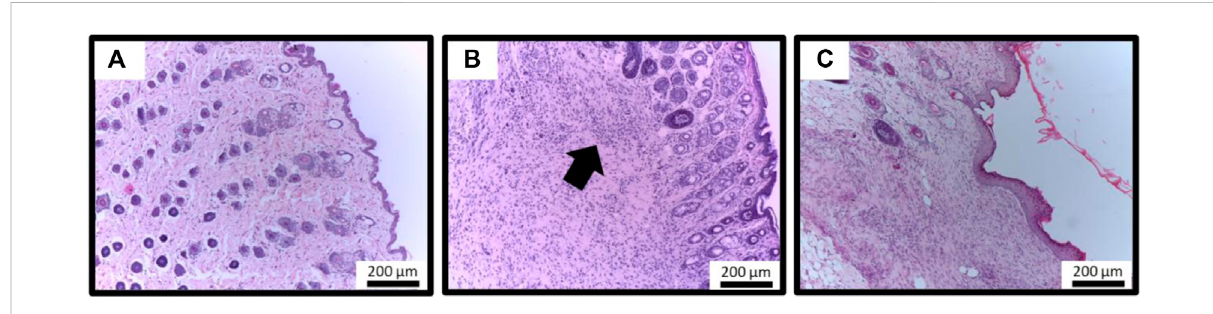
FIGURE 2 Histological evaluation of topical treatment with EbEO. (A) Analysis of wound tissues without S. aureus inoculation (CON group); (B) Analysis of wound tissues infected by S. aureus and without treatment (Sa group); (C) Analysis of wound tissues infected by S. aureus and treated by EbEO (Sa + EbEO group). The intense proin fl ammatory in fi ltrated are highlighted by arrow. 40